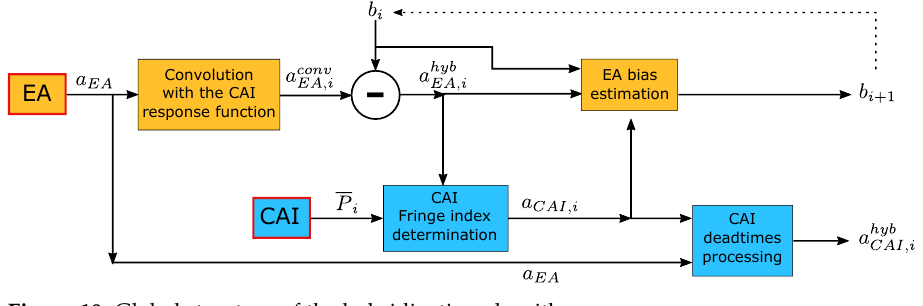
Figure 10. Global structure of the hybridization